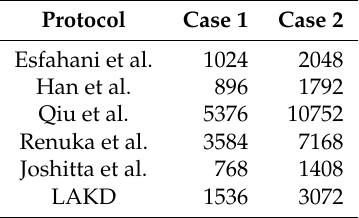
Table 7. Communication-cost of the protocols in bits.